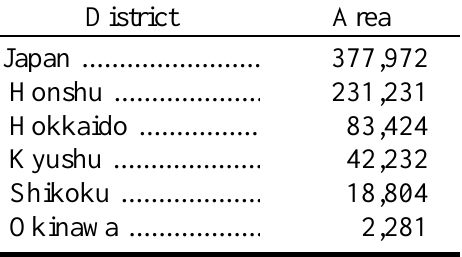
Surface Area of Japan (2016) Top 10 Countries